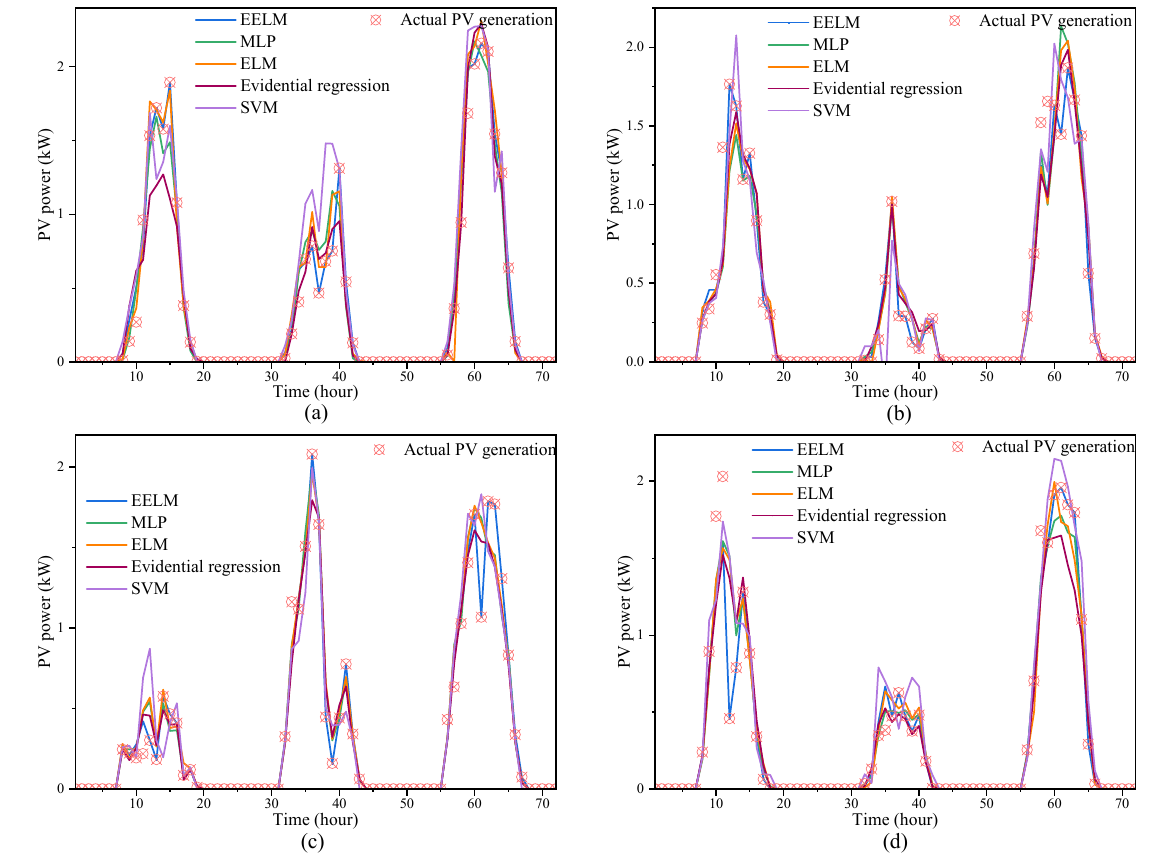
Figure 12. Actual and predicted PV power of various forecasting models for various seasons: ( a ) spring; ( b ) summer; ( c ) autumn; ( d ) winter. Table 2. Forecasting error of various forecasting